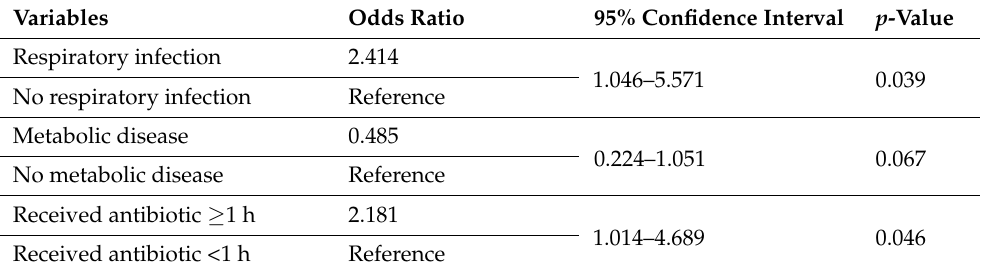
Table 5. Multivariate analysis of association between variables and DIC development in septic pa- tients *.